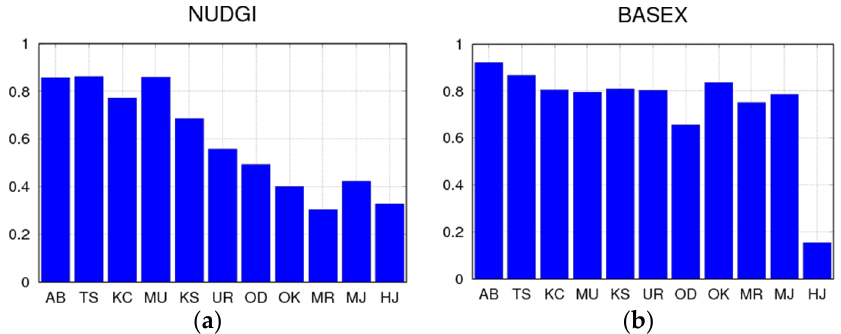
Figure 7. Correlation values between modeled and observed sea level anomaly at the 11 tide gauges sites for the period from 1 July to 31 August 2020(see Figure 3 for the locations). ( a ) case NUDGI, ( b ) case BASEX.